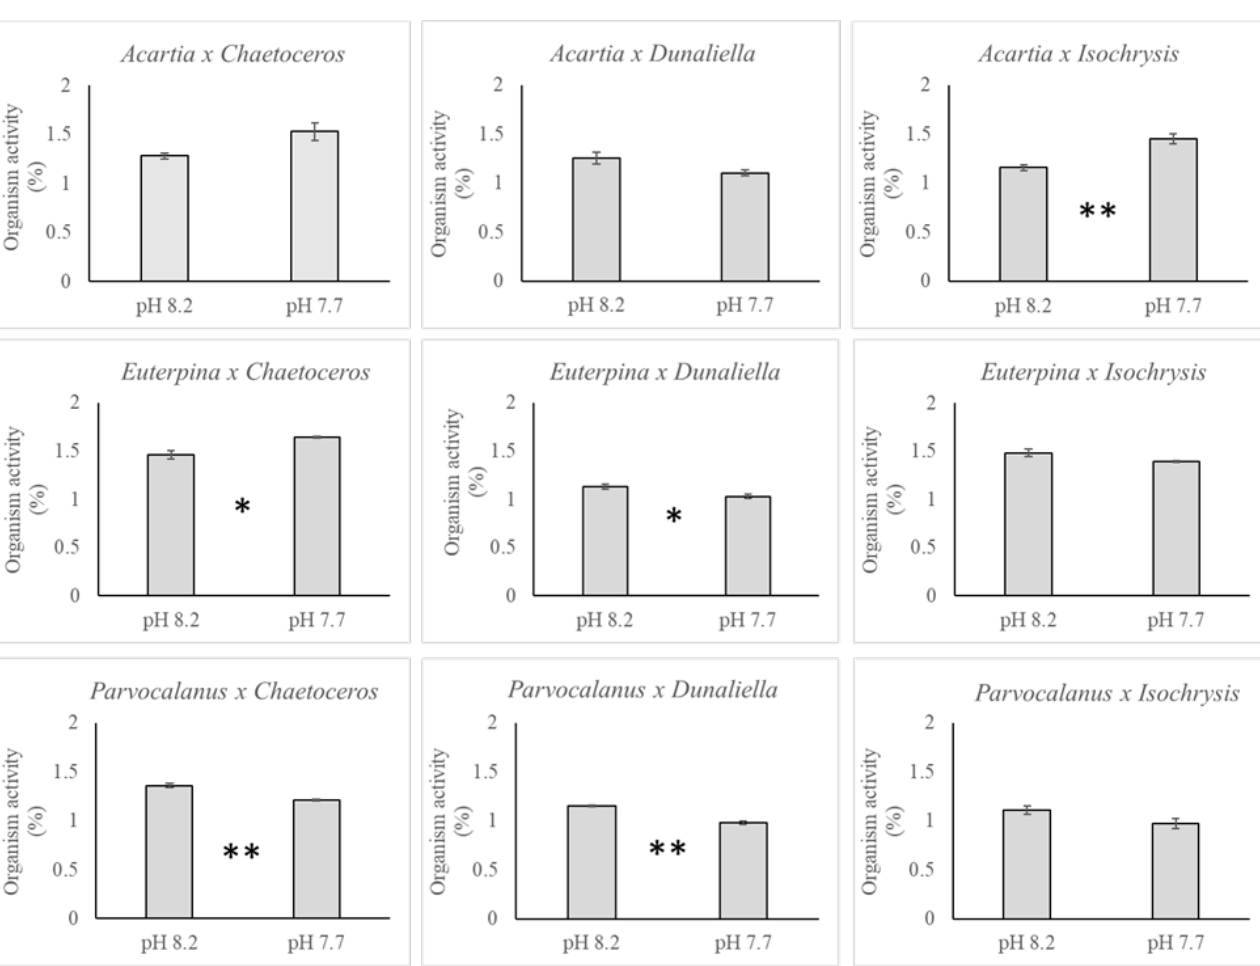
Figure 5. Effect of pH on polonium activity (in %) in the copepod for each combination of copepod species ( Acartia pacifica, Euterpina acutifrons, and Parvocalanus crassirostis ) and microalgae species ( Chaetoceros muelleri, Dunaliella salina, and Isochrysis galbana ). Results are presented as mean±SEM. Significant difference between pH treatments are indicated with * (ANOVA; p < 0.05) and ** ( p < 0.01).